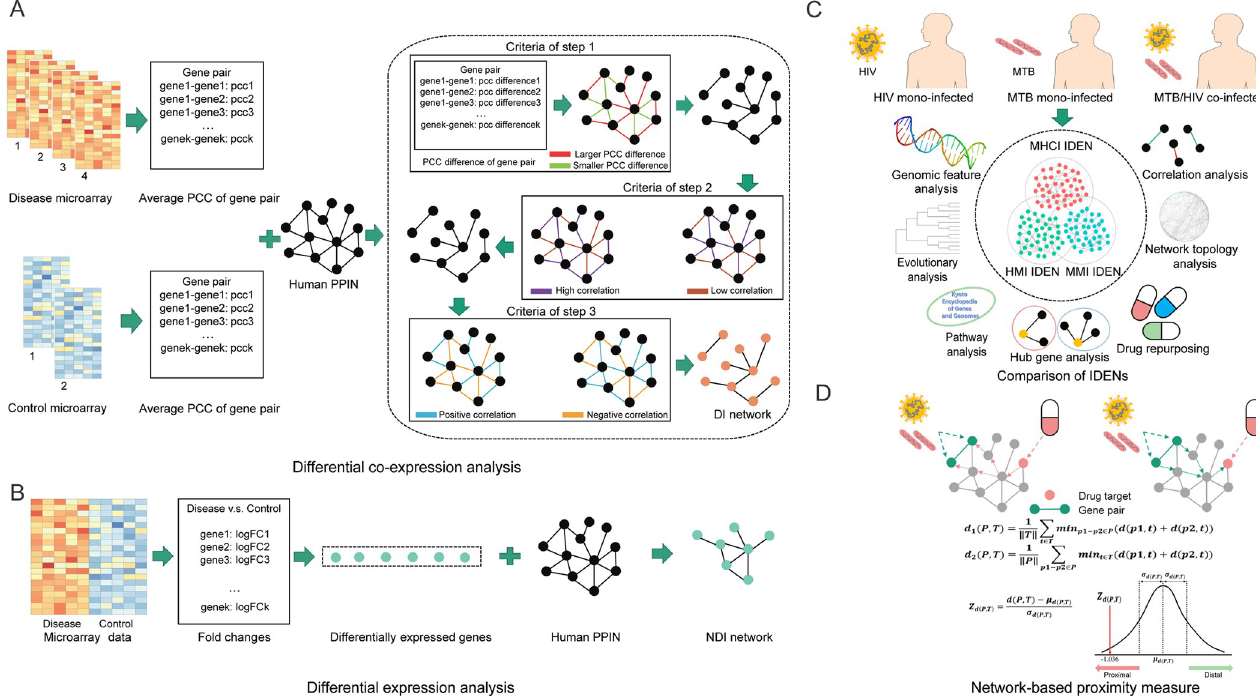
Fig 1. IDEN algorithm and gene pair-based drug repurposing. (A) Flowchart of the DCA method. (B) Flowchart of the DEA method. (C) Comparison of three IDENs. (D) Gene pair-based drug repurposing.